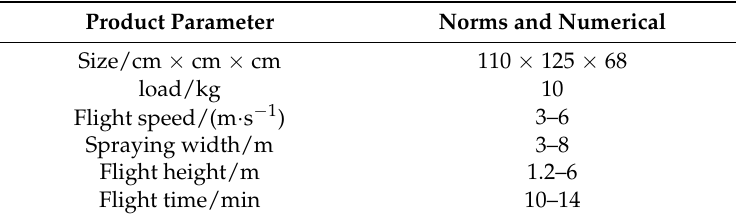
Table 2. Product parameter of JMR-V1200T.